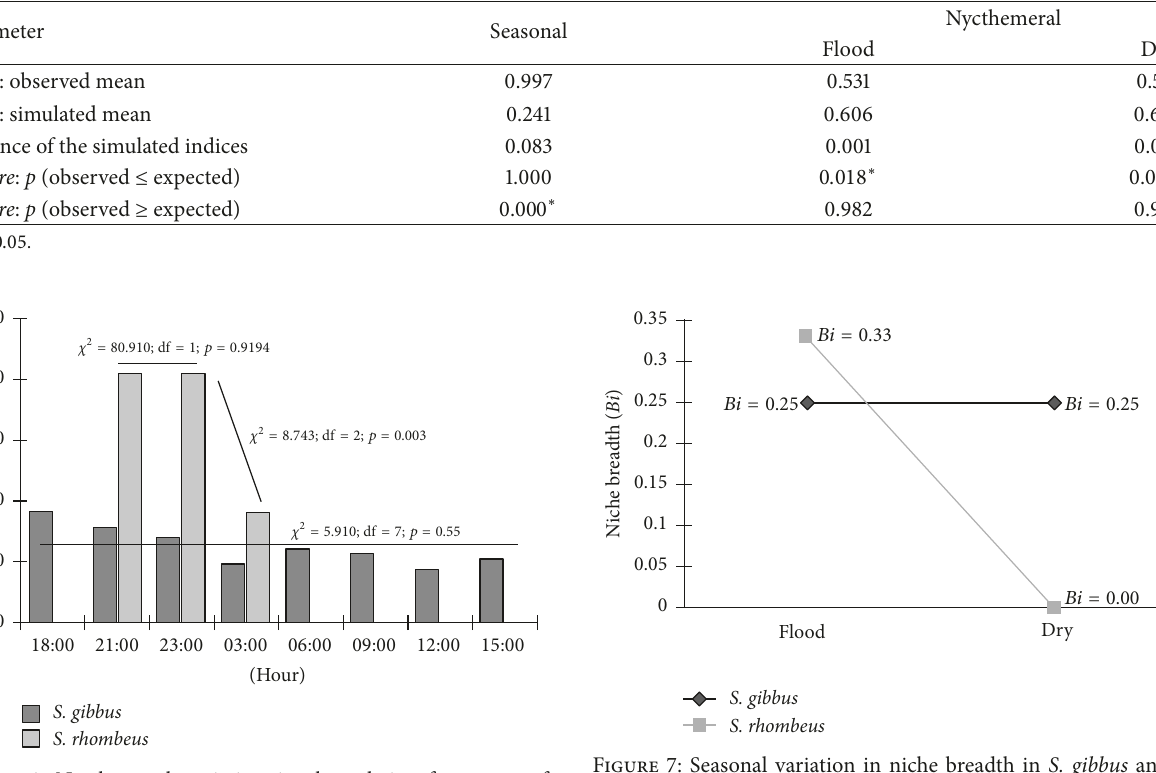
Figure 6: Nycthemeral variation in the relative frequency of repletion of the stomachs (at least partly full) of the S. gibbus and S. rhombeus specimens collected in the Coaracy Nunes reservoir in Ferreira Gomes, Amap´a (Brazil).